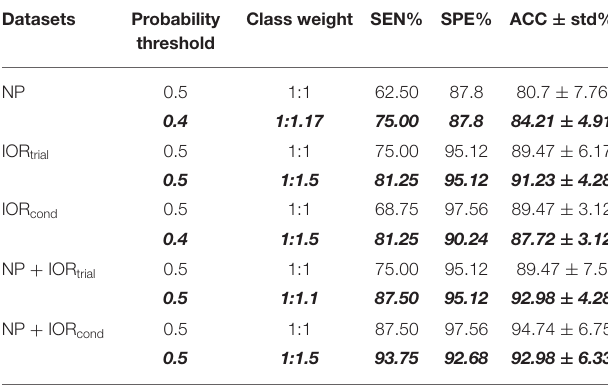
TABLE 2 | Multilayer perceptron (MLP) classification performance using the demographically comparable dataset.